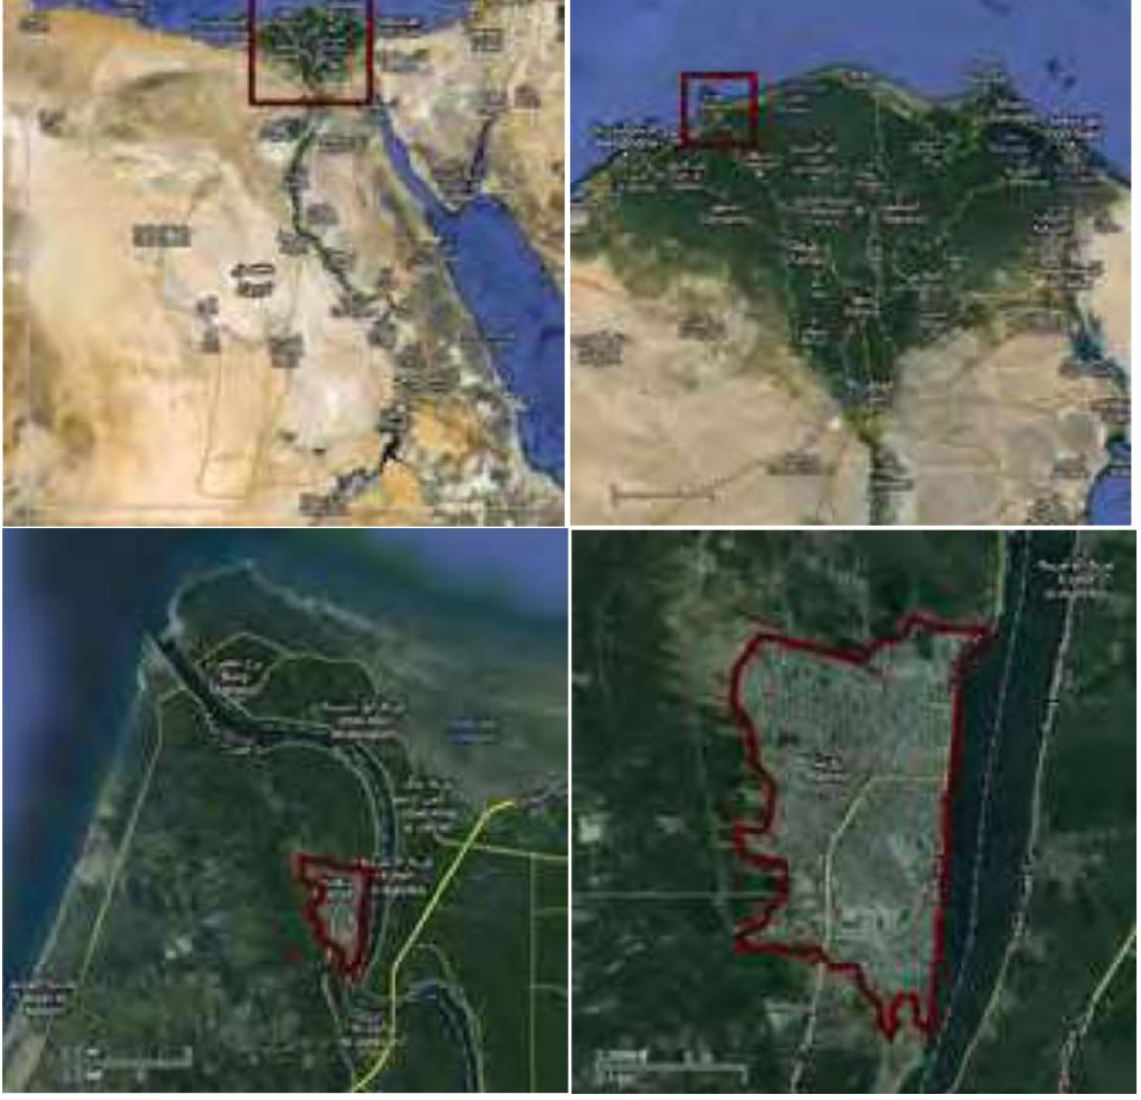
Figure 1. Rosetta location - Source: Google